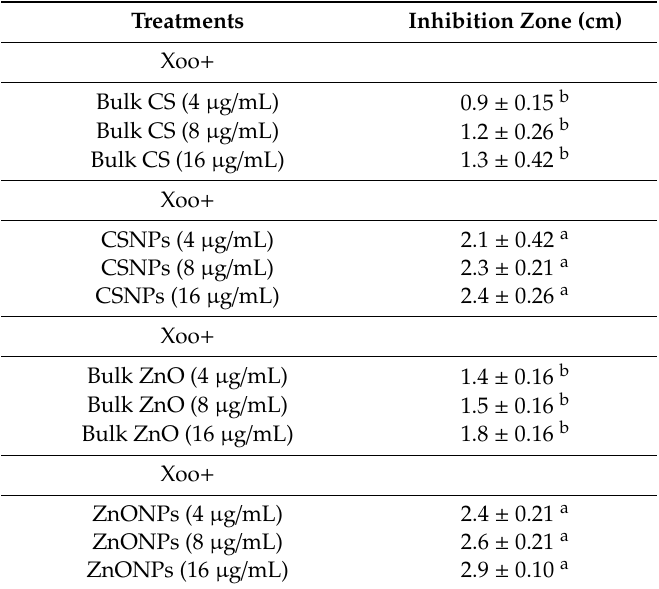
Table 1. The inhibitory e ff ect of bulk chitosan (CS), chitosan nanoparticles (CSNPs), bulk ZnO, and zinc oxide nanoparticles (ZnONPs) on the growth of Xanthomonas oryzae pv. oryzae strain GZ0005 in nutrient agar plates.